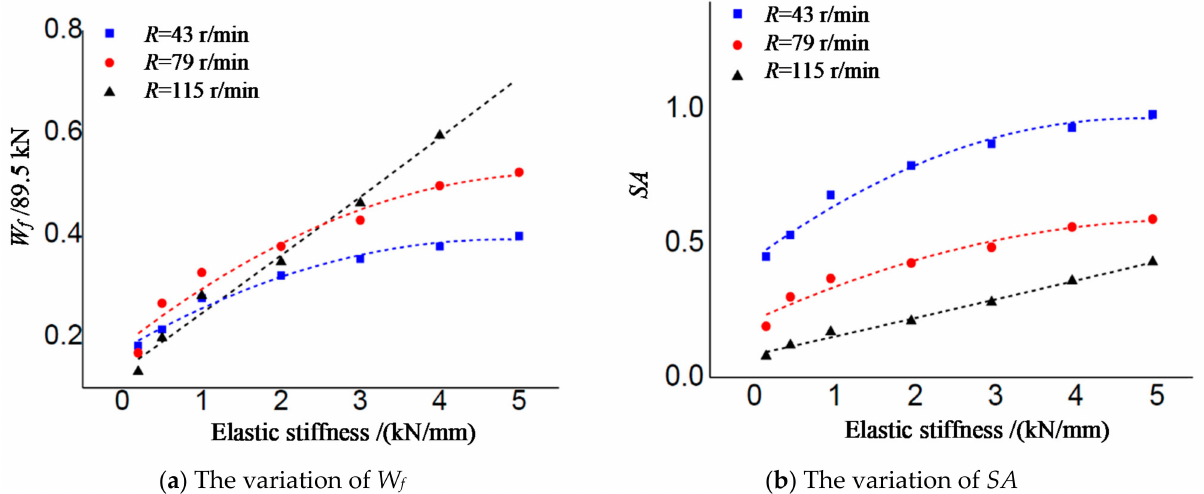
Figure 8. The variation of W f and SA with spring elastic